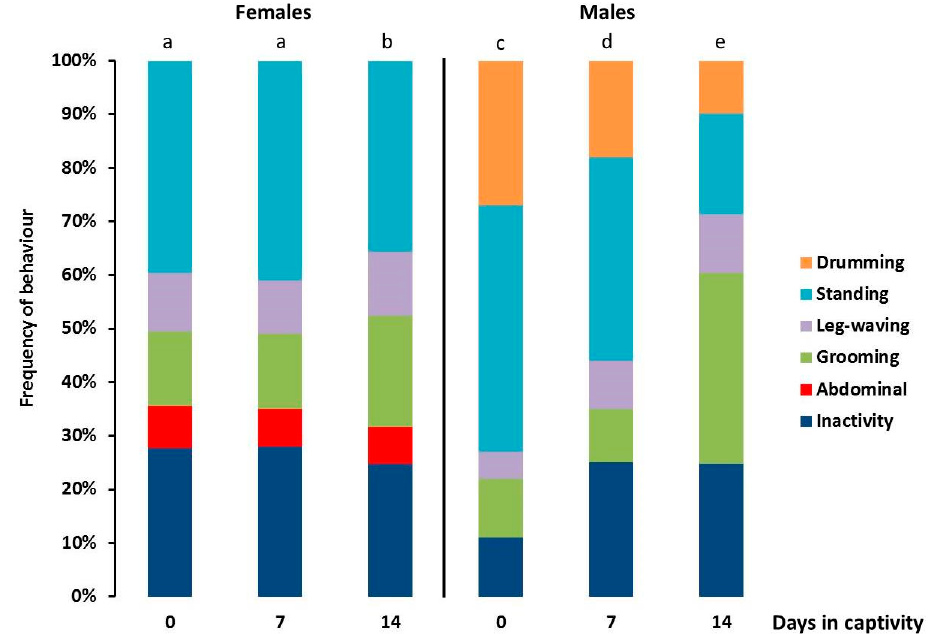
Figure 5. Spontaneous behavioural activities without changing position of adult female and male Pardosa saltans (in frequencies) in terraria after capture in their natural environment (0 day in captivity), seven days after capture (7 days in captivity) and 14 days after capture (14 days in captivity). Frequencies of behavioural events were compared using generalised linear mixed mod (GLMM, negative binomial distribution). Different letters indicate a significant difference ( p < 0.050, post hoc Wald test).